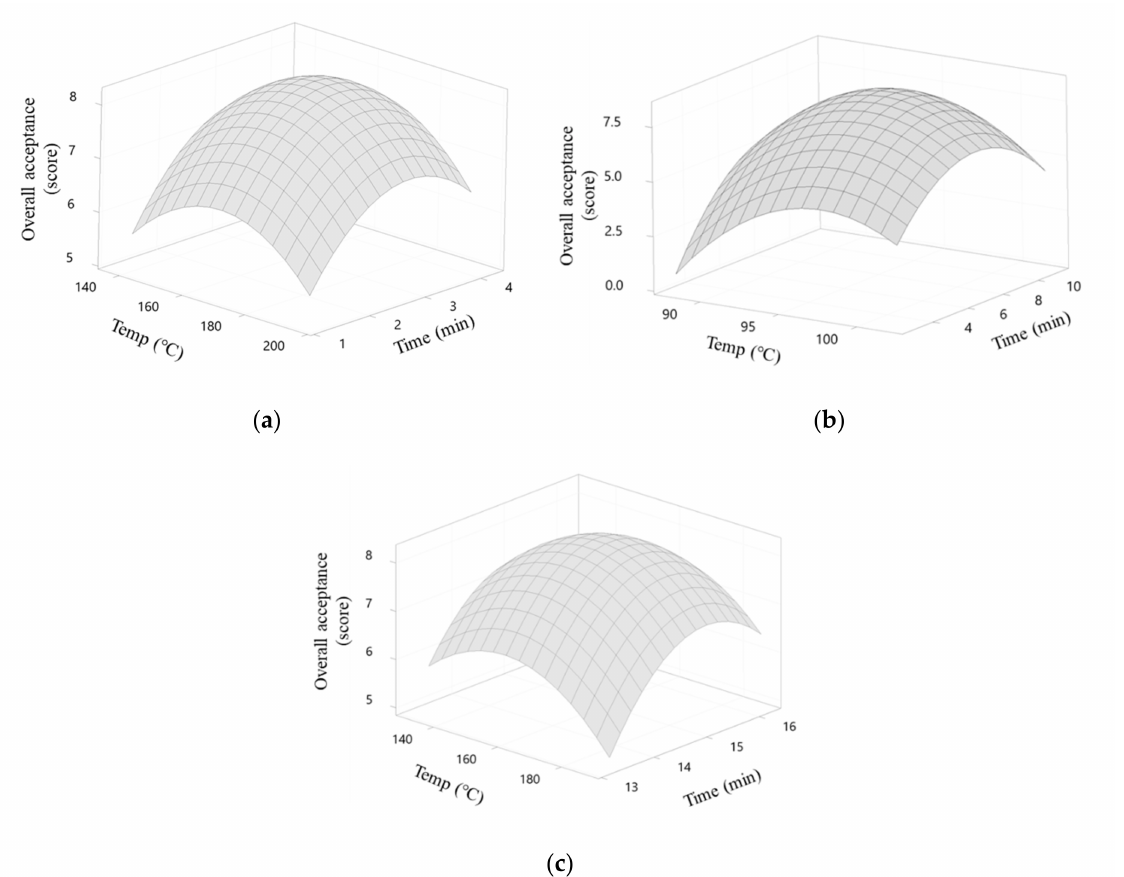
Figure 2. Three-dimensional response surface plots of ( a ) deep fried, ( b ) vacuum fried, and ( c ) air fried chub mackerel ( Scomber japonicus